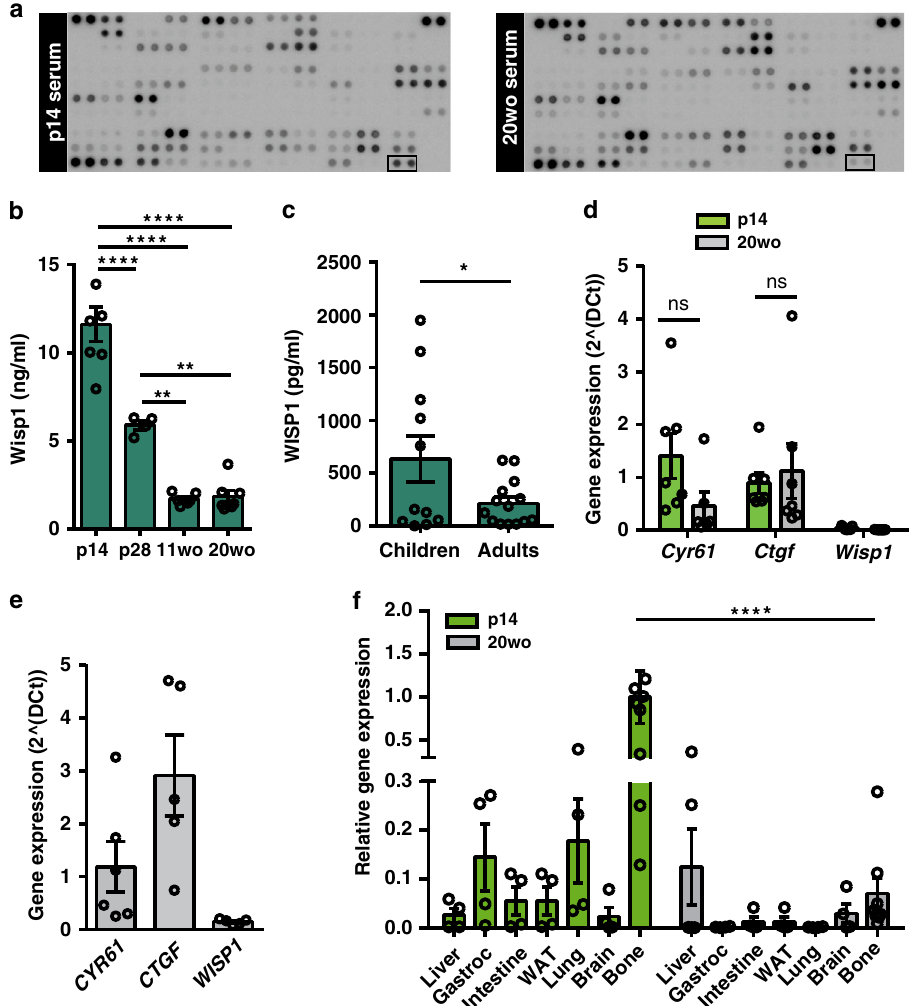
Fig. 2 Identi fi cation of Wisp1 as a factor enriched in blood of pre-weaning mice. a Representative images of antibody arrays incubated with p14 or 20wo mouse serum. Spots corresponding to Wisp1 are marked with an empty square box. b Serum levels of Wisp1 in p14 ( n = 7), p28 ( n = 4), 11wo ( n = 6) and 20wo ( n = 7) mice measured with ELISA. c Plasma levels of WISP1 in children ( n = 11) and adult ( n = 14) measured with ELISA. d Quanti fi cation by qPCR of the expression of the indicated CCN genes in p14 ( n = 7, green) and 20wo mouse islets ( n = 6 for Cyr61 , n = 7 for other genes, gray). Values are expressed relative to Tbp . e Quanti fi cation by qPCR of the expression of the indicated CCN genes in adult human islets ( n = 6 for CYR61 , n = 5 for other genes). Values are expressed relative to TBP . f Quanti fi cation by qPCR of Wisp1 gene expression in the indicated p14 (green) and 20wo (gray) mouse tissues. Wisp1 gene expression is shown relative to levels in p14 bone, given the value of 1 ( n = 9 for bone, n = 4 for all other tissues). WAT: white adipose tissue; Gastroc: gastrocnemius. All data shown represent mean ± SEM from the indicated n . Indicated comparisons were made using two-tailed Student ’ s t test ( c , d ), one-way ( b ) and two-way ( f ) ANOVA. * p < 0.05; ** p < 0.01; **** p < 0.0001; ns: not signi fi cant. In f , at p14, bone Wisp1 gene expression was signi fi cantly higher than in all other tissues tested with p < 0.01 –